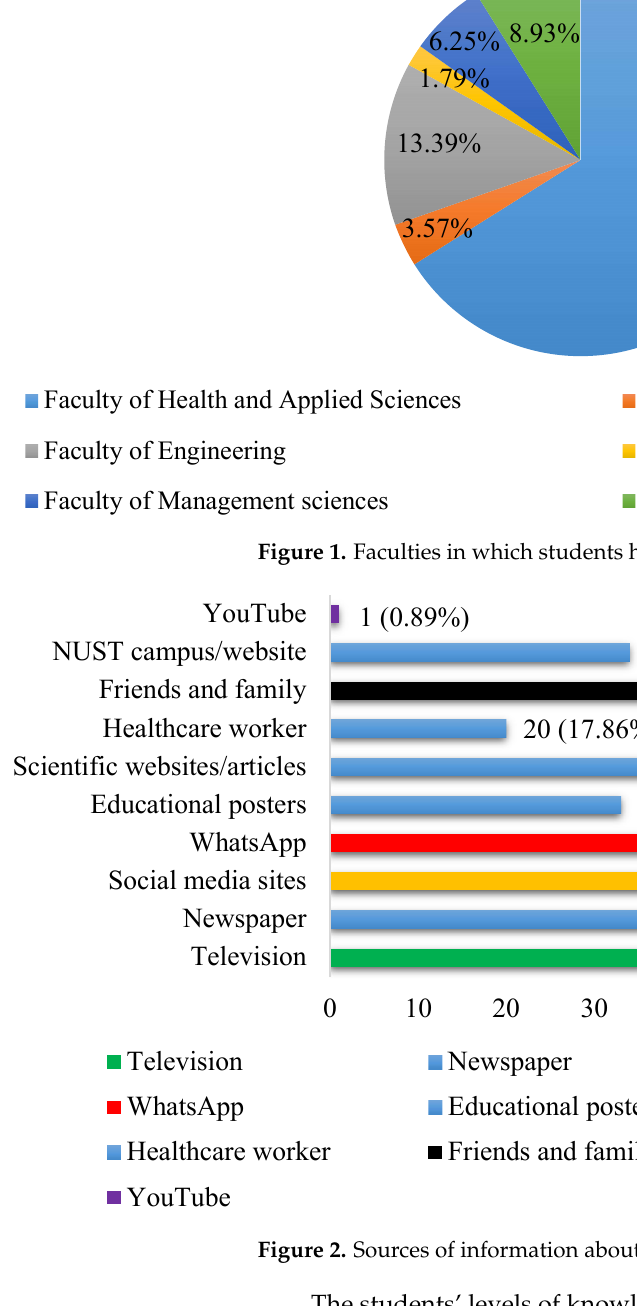
Figure 2. Sources of information about COVID-19 students’ levels of knowledge about COVID-19. through sexual intercourse or water while swimming. The average mean score about the modes of transmission of COVID-19 was 4.73 ± 1.031 (range, 0–6) with an average knowledge level of 78.83% ([4.73/6] ×